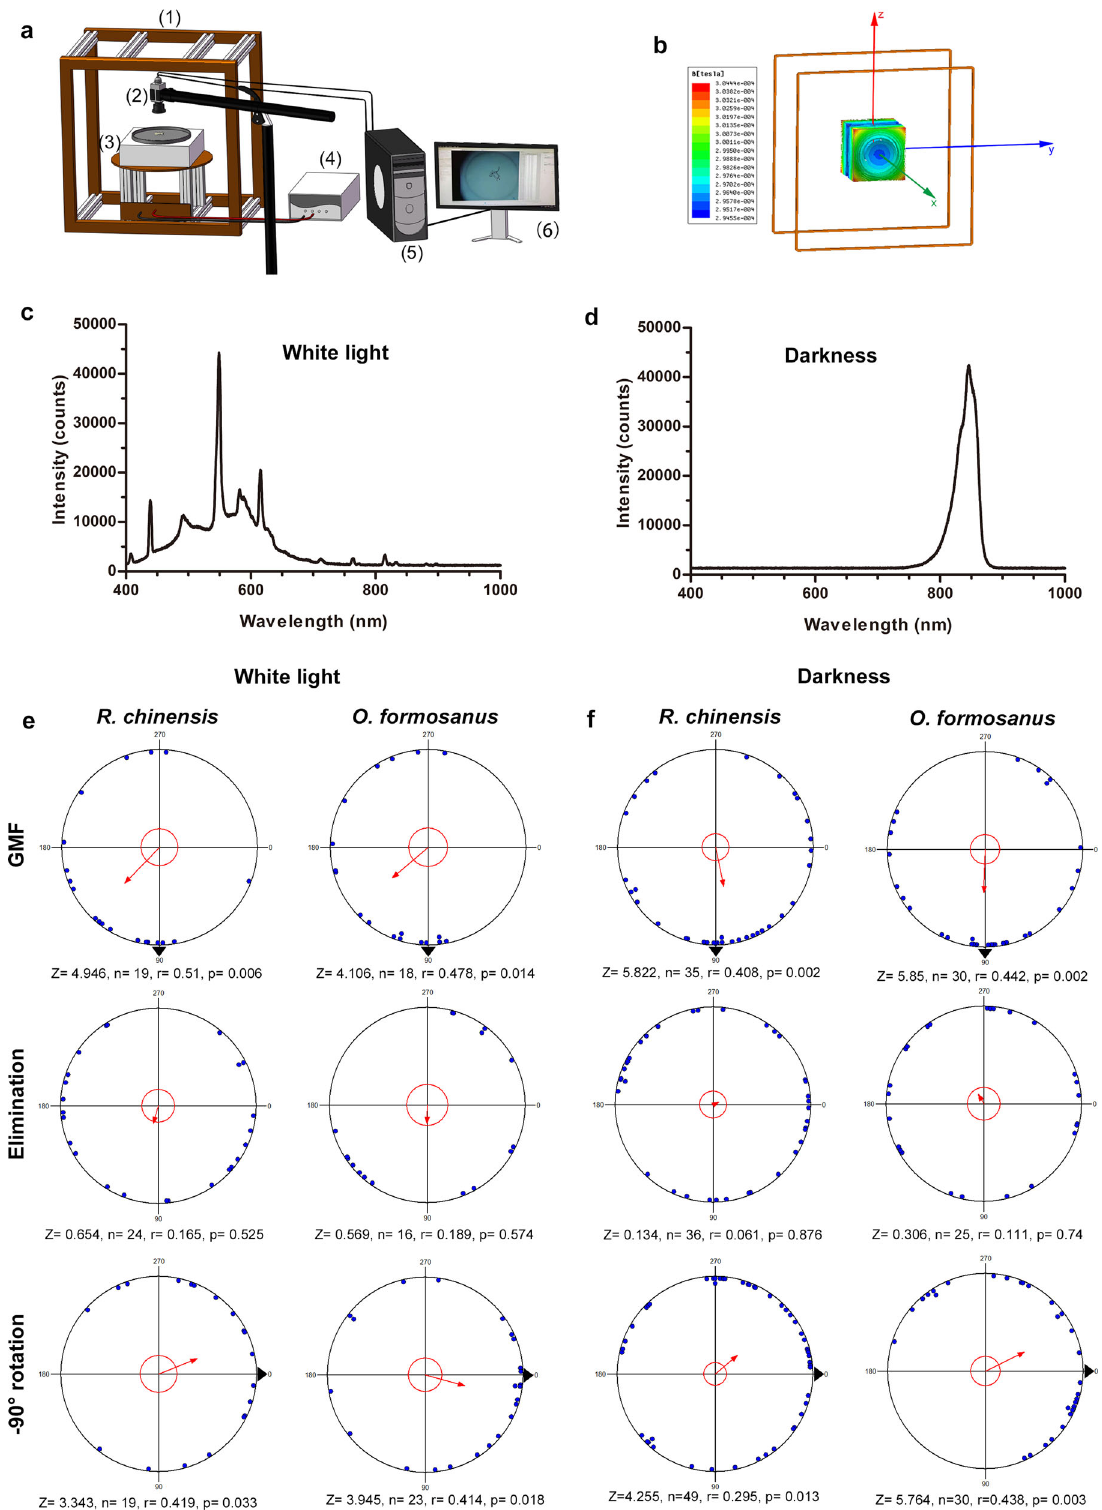
heading direction during walking in white light and complete darkness. We further found that the directional preference of the termites changed when the horizontal component of the magnetic fi eld was rotated. When the horizontal component of the magnetic fi eld was rotated 90° relative to the GMF orientation, the direc- tional preference of the termites changed (Rayleigh test, White light: R. chinensis , r = 0.419, p = 0.033, O. formosanus , r = 0.414,